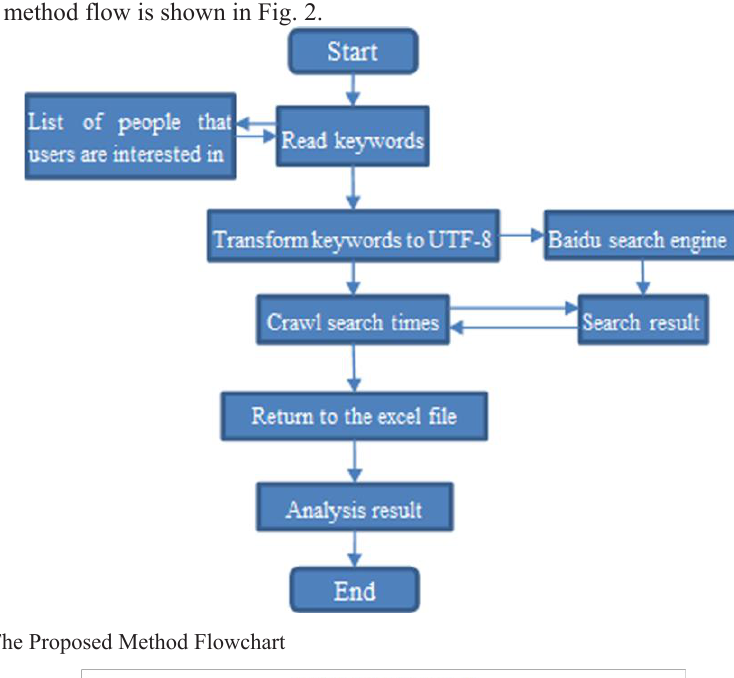
Fig. 2. The Proposed Method Flowchart